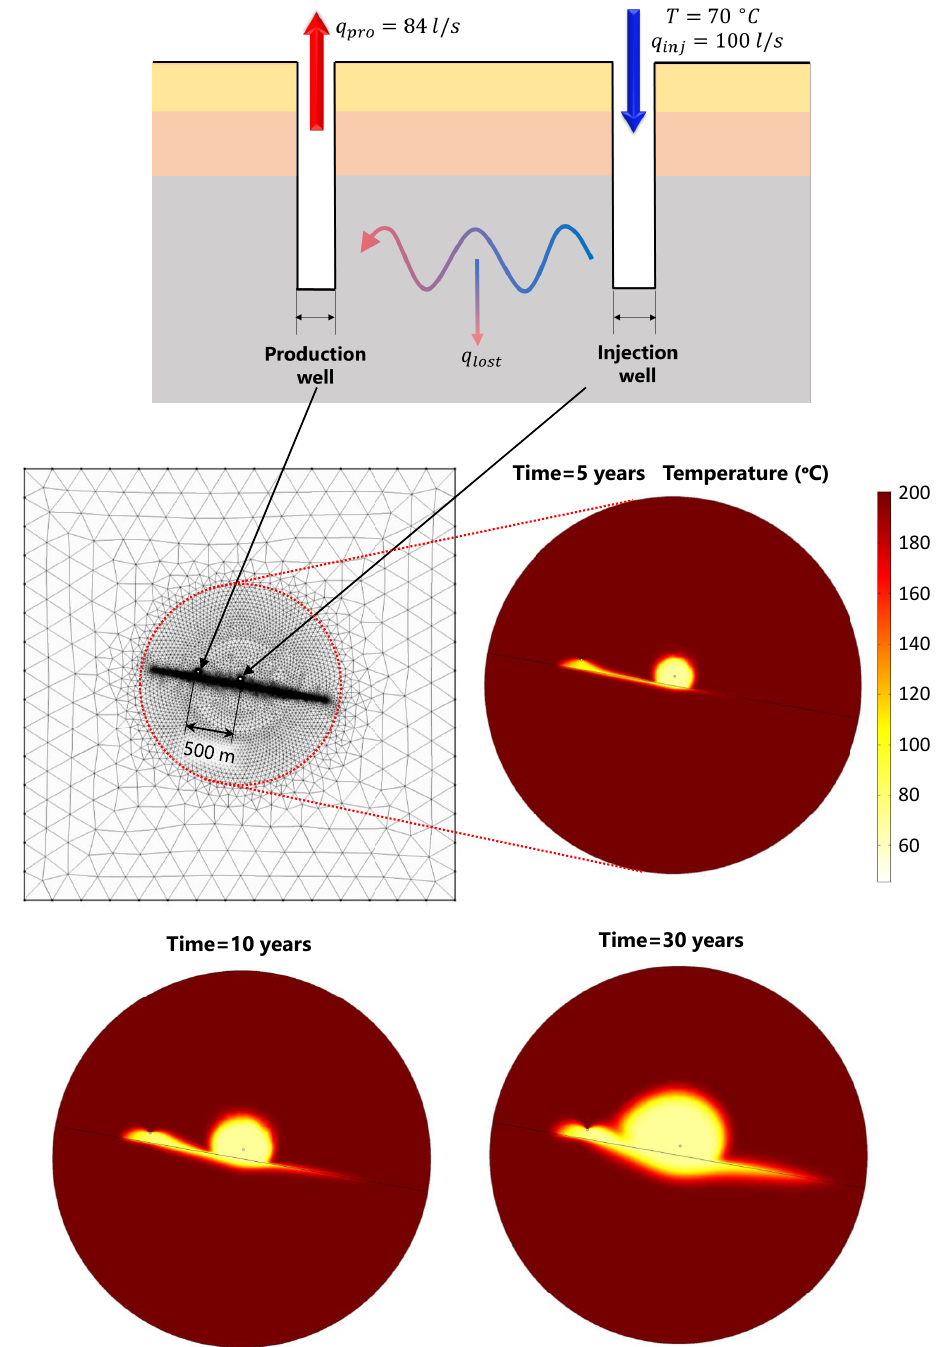
Figure 6. Evolution of the temperature in the reservoir for a long-term operation scenario. We show the simulated injection and production scheme, so the injection flow rate is 100 l/s at 70 ◦ C and the production flow rate is 84 l/s. We include temperature results for 5, 10, and 30 years, showing that heat transport initially occurs by advection in the vicinity of the fault and later extends to wider areas around the injection